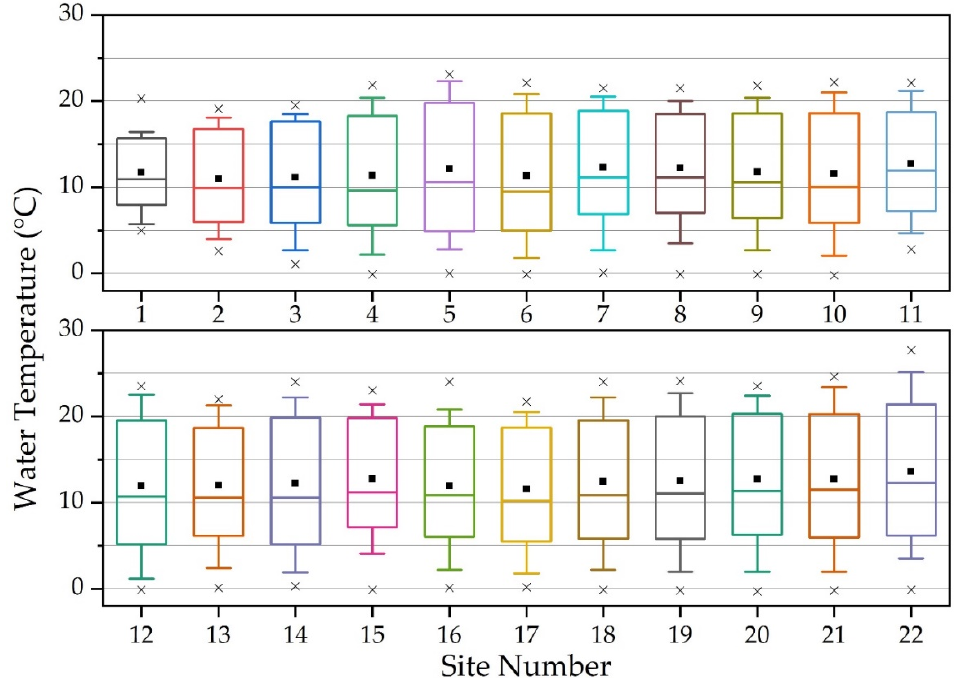
Figure 4. Box and whisker plot of water temperature (°C) descriptive statistics at 22 sampling locations during study period (2 January 2018–1 January 2019) in West Run Watershed, Morgantown, WV, USA. Box delineates 25th and 75th percentiles; line denotes median; square shows mean; whisker describes 10th and 90th percentiles; x shows maximum and minimum when above and below, respectively.